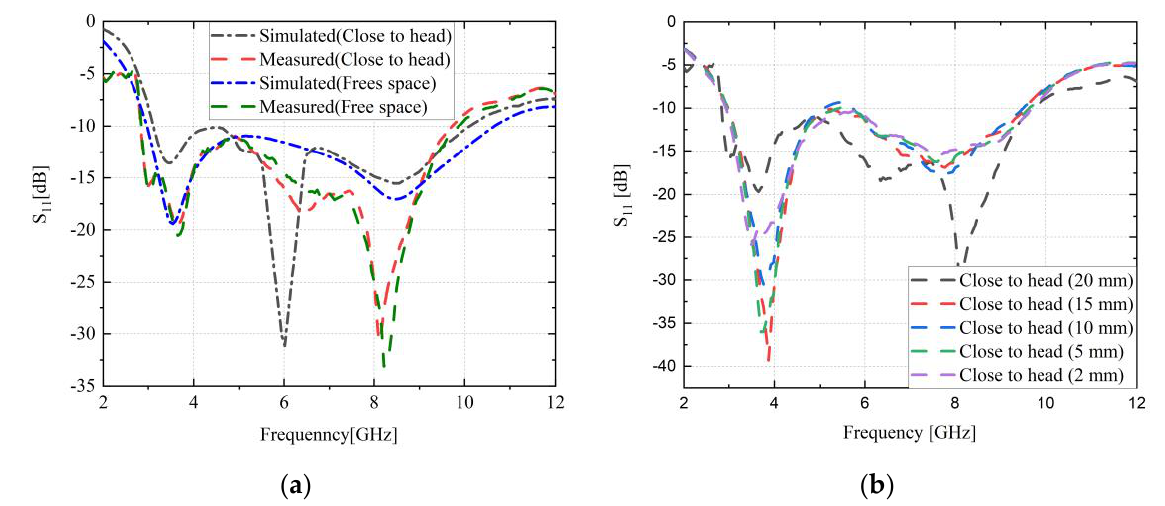
Figure 9. Simulates and measures the return losses of the proposed antenna in free space and close to the human head .